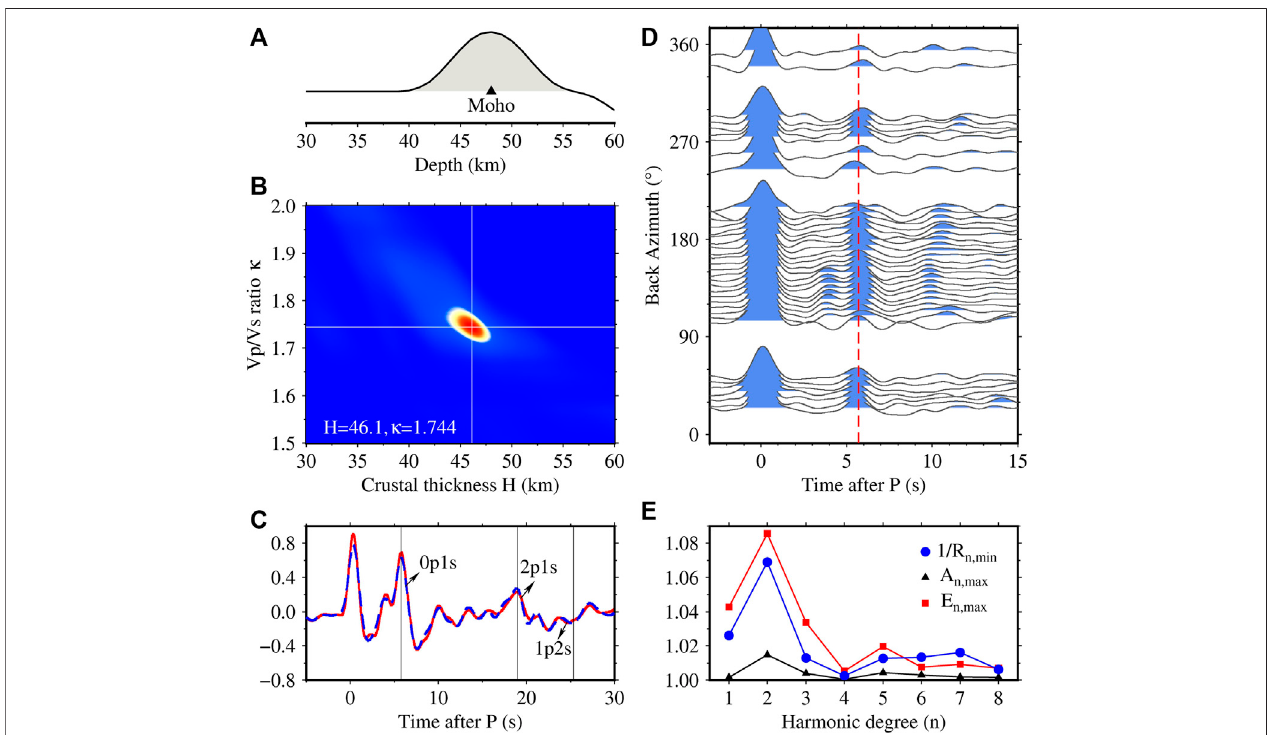
FIGURE 2| (A) denotes the stacked receiver function after the time-to-depth conversion ofstation 15,819. The maximum peak marked byblack triangle indicates the initial Moho depth. (B) is the result of H- κ analysis at station 15,819. The cross white lines indicate the location of the peak amplitude. (C) shows the time domain stacked receiver functions with the Ps slowness (red solid line) and the 2p1s slowness (blue dashed line). Note that amplitude of the phases is larger when they are stacked with the correct slowness. (D) plots the radial receiver functions as a function of back azimuth at the station 15,819. The red dashed lines denote the average arrival time of the Moho Ps phase. (E) indicates the result of harmonic analysis at station 15,819. The reciprocal of the minimum residual, the maximum value of peak amplitude and total energy are plotted as a function of the harmonic degree.